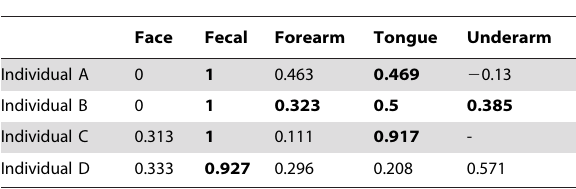
Table 2. Results of ANOSIM tests comparing the affect of extraction method on bacterial community composition (unweighted UniFrac) of each body habitat from each individual.